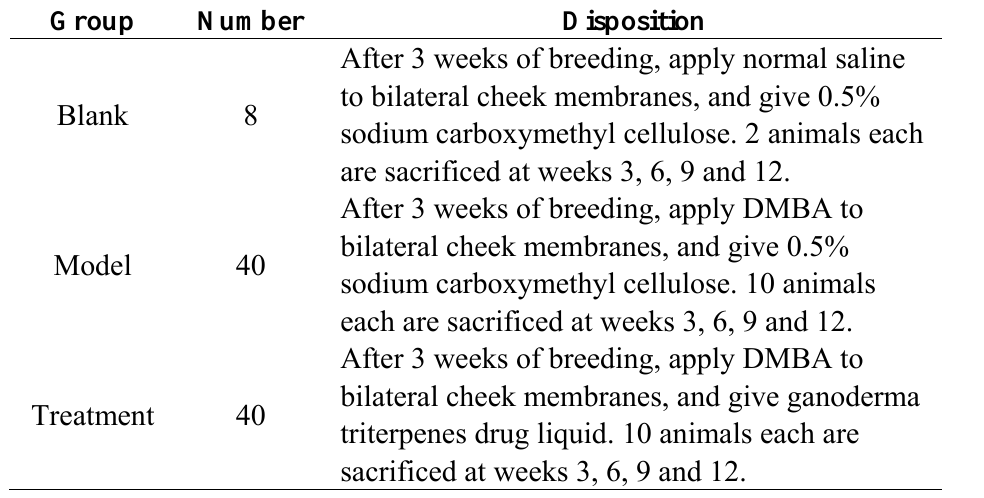
Table 8. Group allocation and disposition of test